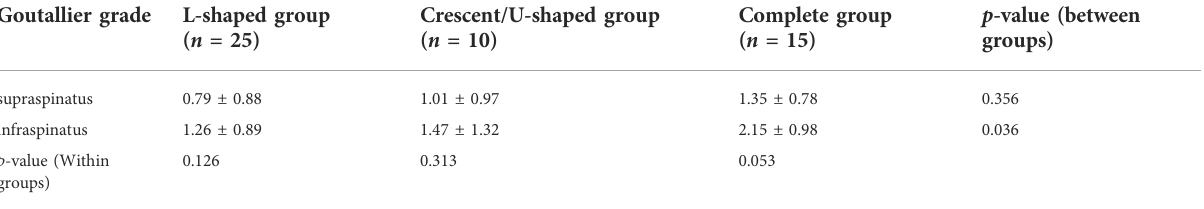
TABLE 1 Comparisons of Goutallier grade of supraspinatus and